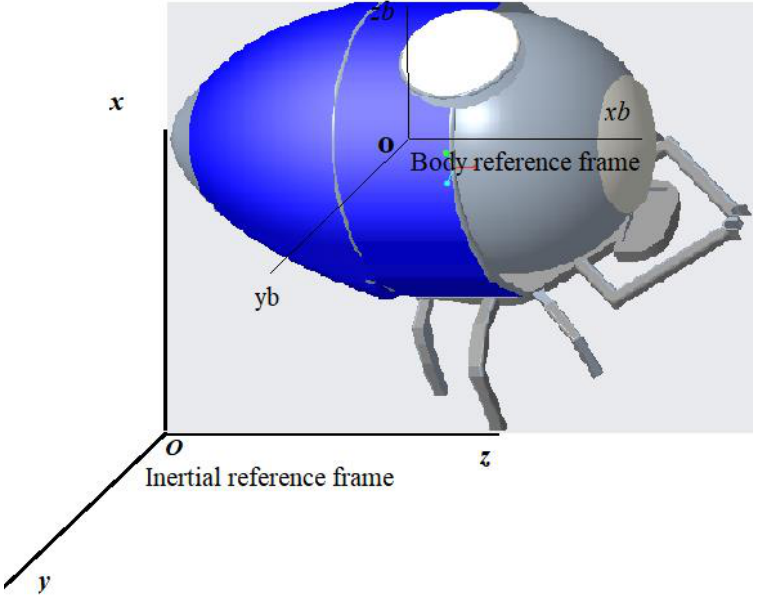
Figure 20. Representation of body and inertial reference frame.